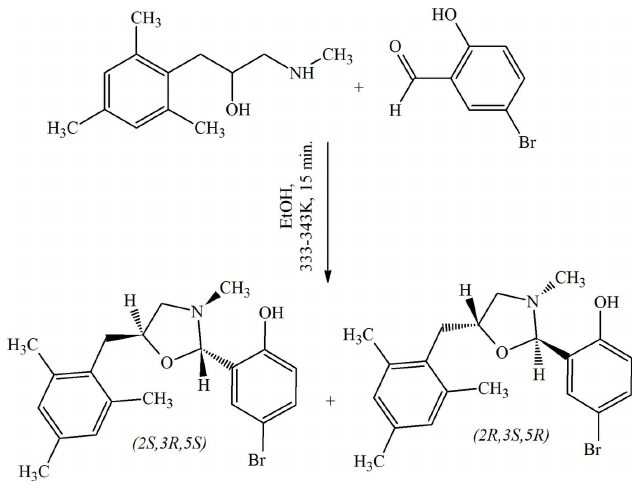
Figure 1 Synthesis of the racemic mixture of 2 R ,3 S ,5 R - and 2 S ,3 R ,5 S